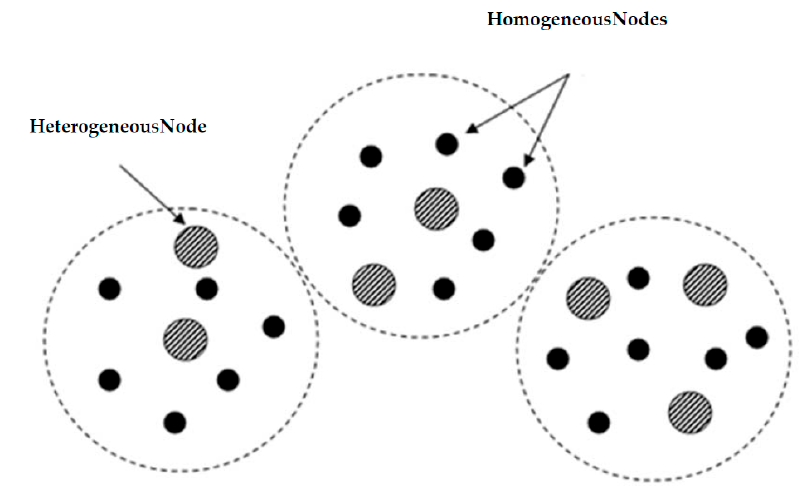
Figure 1. Heterogeneous Wireless Sensor Network.